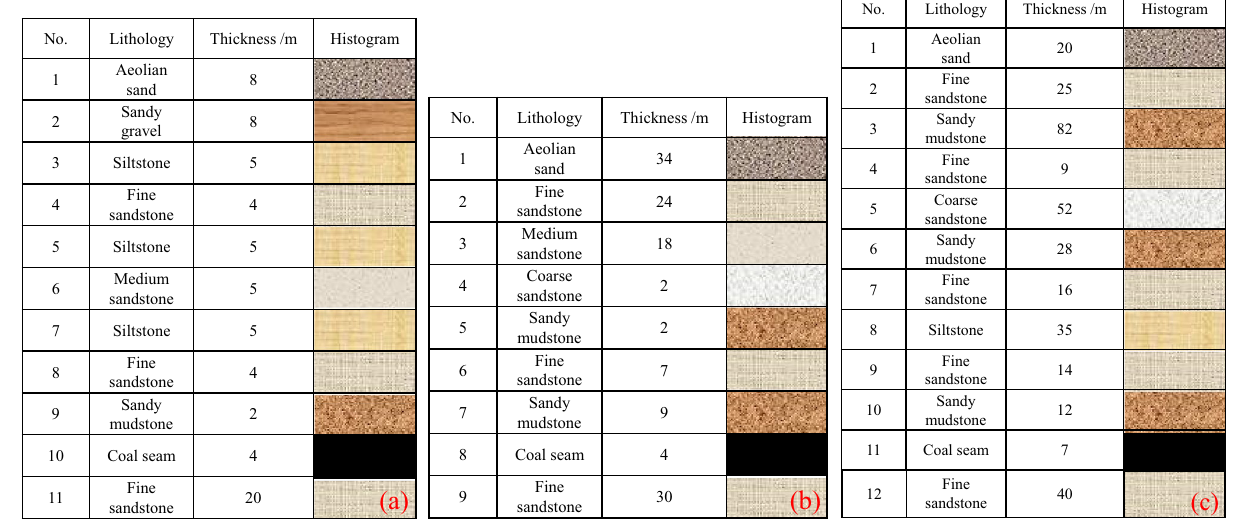
Figure 10. Distribution of coal and rock strata with different burial depth. ( a ) Buried depth 50 m. ( b ) Buried depth 100 m. ( c ) Buried depth 300